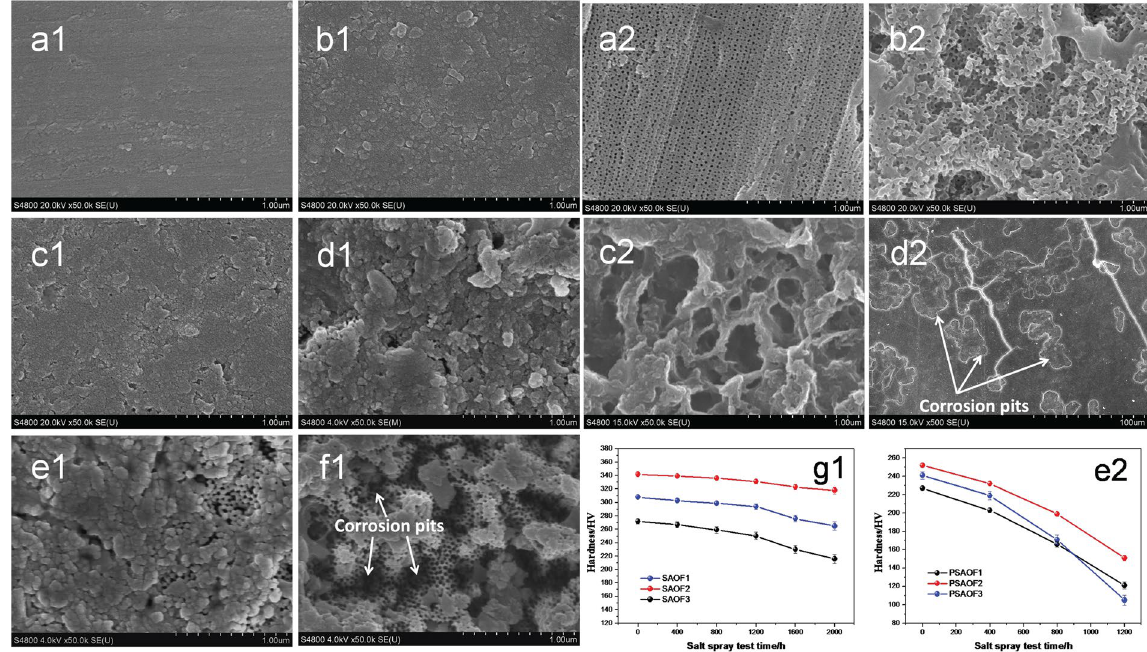
Figure 3. Surface morphologies and microhardness of SAOF and PAOF corroded with different SST time, (a1 and a2) 0 h, (b1 and b2) 400 h, (ca and c2) 800 h, (d1 and d2) 1200 h, (e1) 1600 h, (f1) 2000 h, g1 and e2 showed microhardness decreased with